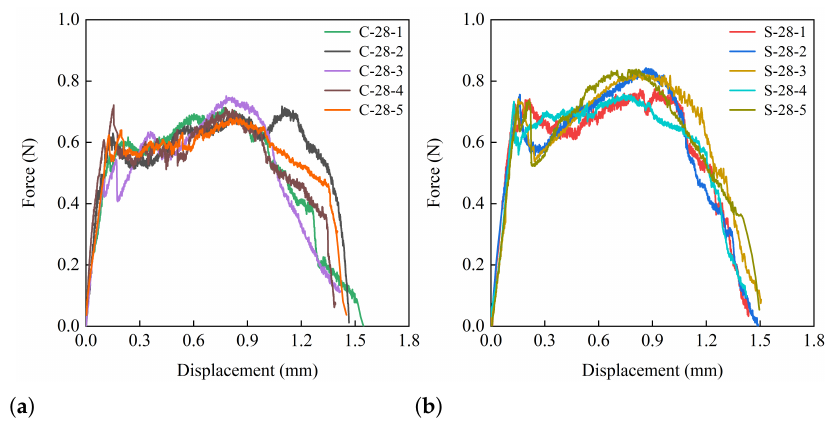
Figure 16. Single fiber pullout curve ( a ) control-ECC ( b )